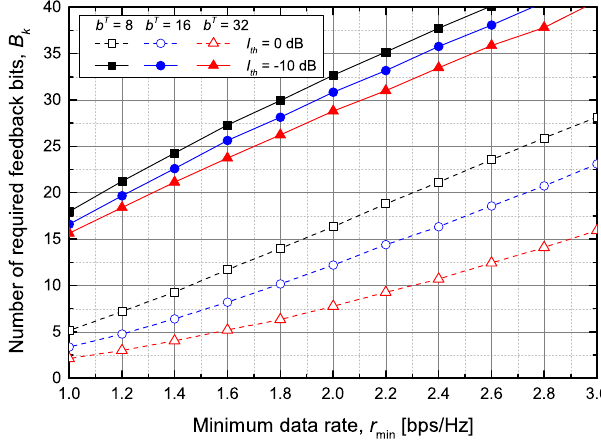
Figure 7. The average number of required feedback bits between ST k and PUs.